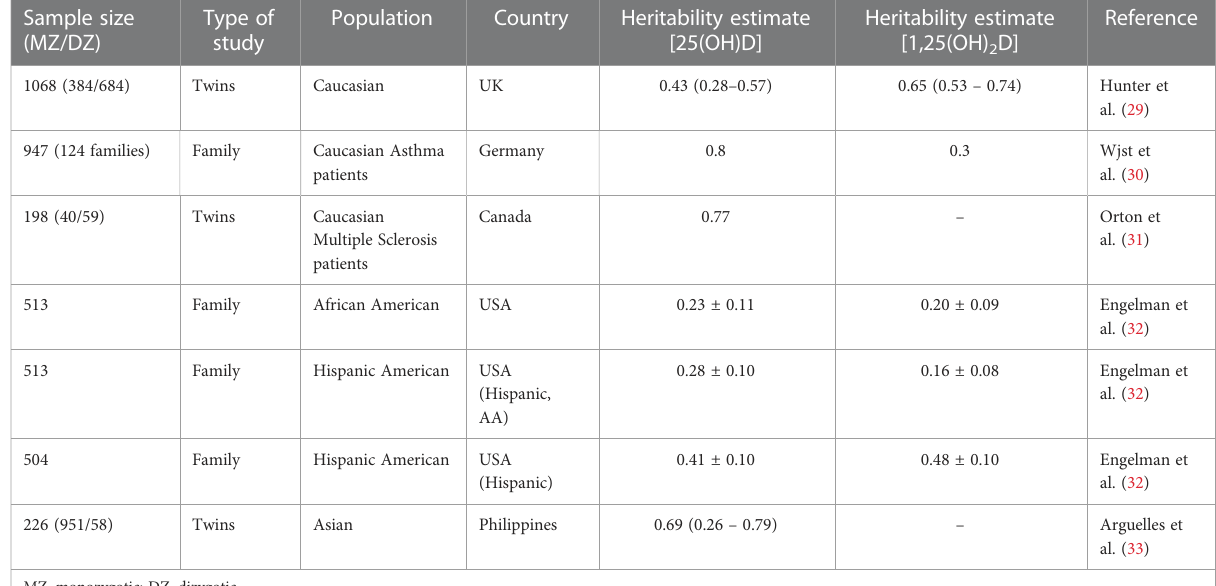
TABLE 1 Twin and familial studies of circulating 25(OH)D and 1,25(OH) 2 D levels with measures of heritability (0.1 = 10%). Sample